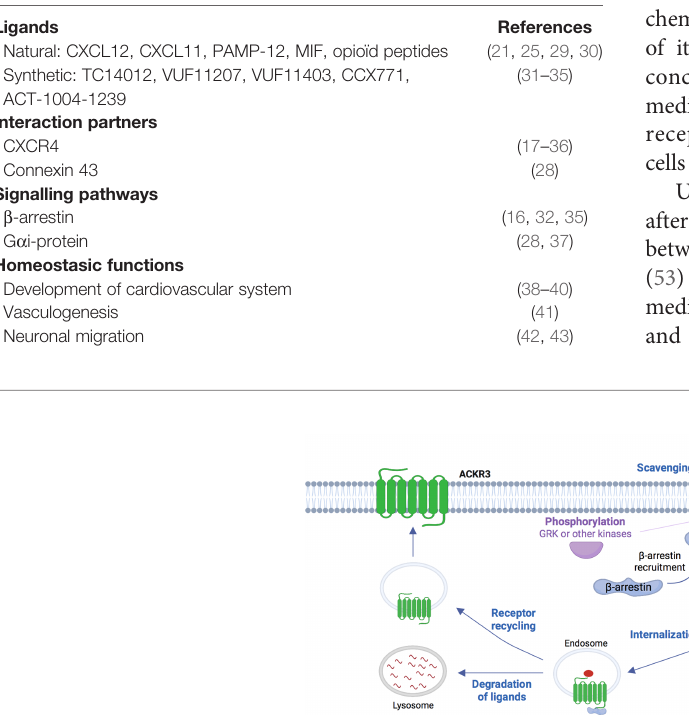
TABLE 1 | ACKR3: ligands, signalling and functions.